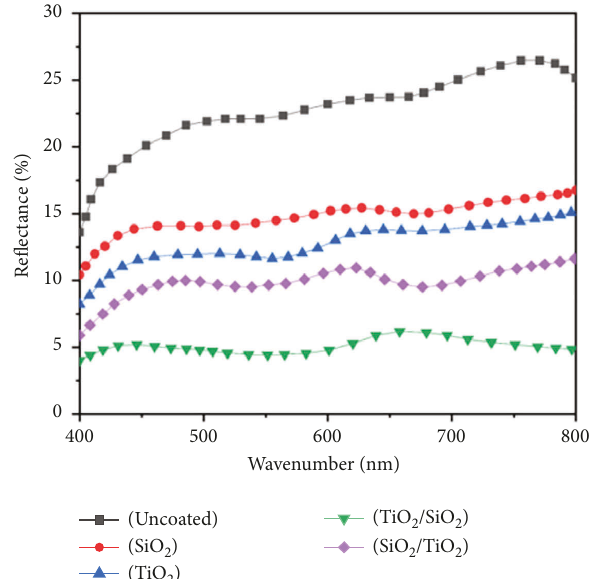
Figure 6: Optical reflectance spectra of various solar